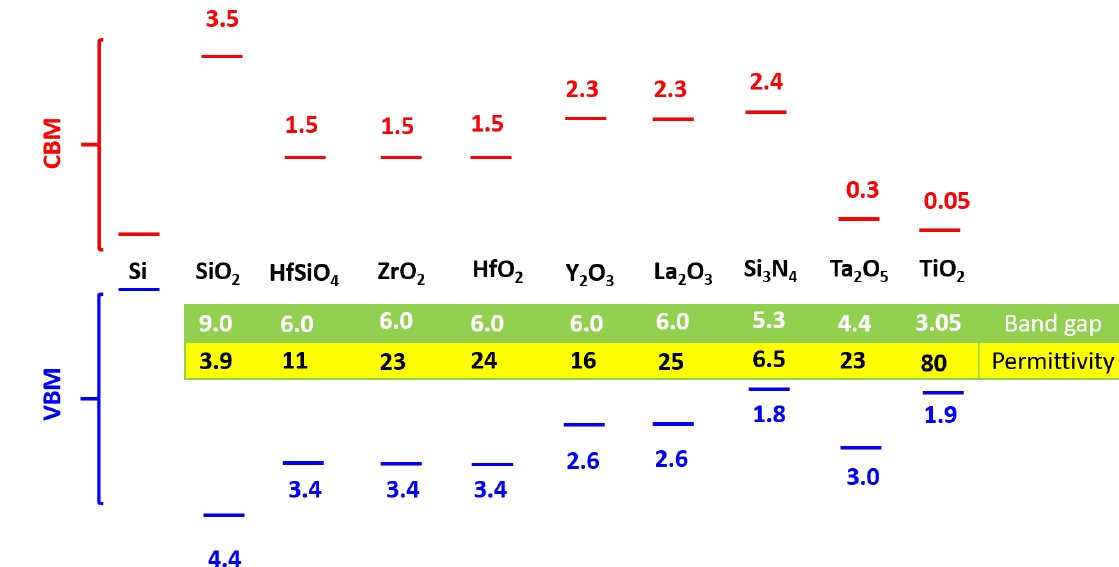
Figure 5. Comparison of the dielectrics in conduction and valence band offsets and permittivity.